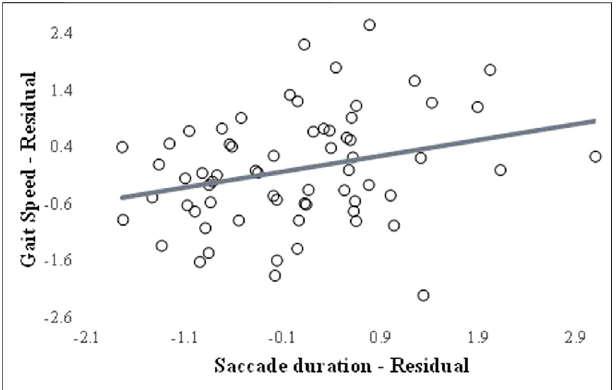
FIGURE 2 | Scatter plot between the residuals of saccade duration and gait